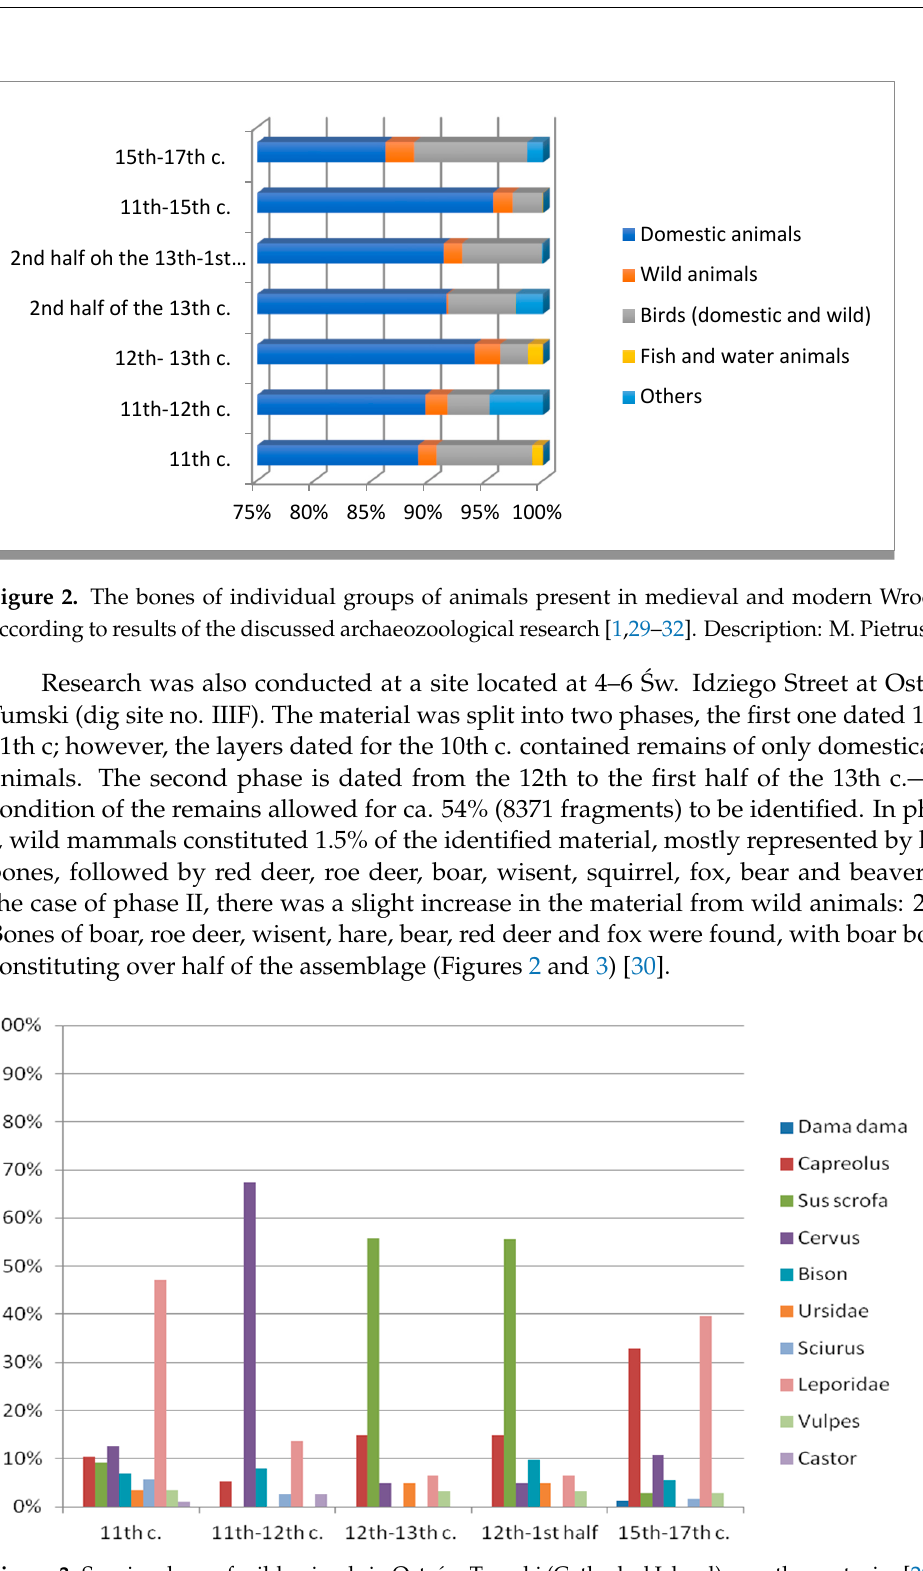
Figure 3. Species share of wild animals in Ostrów Tumski (Cathedral Island) over the centuries [29,30] (species names in Latin). Description: M. Pietruszka. Items made from bones and antlers found at Ś w. Idziego Street at Ostrów Tumski came from layers dated for the 11th c. Apart from some identified items and fragments of raw material, some artifacts were identified. One of the most interesting finds was a comb (Figure 4) made from deer antler, whose presence is proof of contact with the settlements of the Western Pomerania. Such provenance is indicated by the form and ornamentation of the comb. The comb, despite its fragmentary preservation, was typologically analysed and identified as a representative of group IB, type VII, variation 6, subvariation c, in the classification by Cnotliwy (1973), i.e., a single-sided comb with narrow, arched fittings and toothed plates with wavy top edges, decorated with a row of holes [41]. Additionally, other items were identified, such as a tourniquet made of deer antler, conical fittings that may have been used to reinforce knife handles, a small arrowhead made of deer antler and bone (bear or horse bone) and antler (red or roe deer) spikes [41]. Ś w. Idziego Street also yielded numerous leather fragments. Their condition, however, prevents any precise identification. A piece of goat or deer leather, decorated with embroidery, comes from the third quarter of the 11th c. A leather scrap from a cut shoe vamp is dated for the turn of the 12th c. [37].